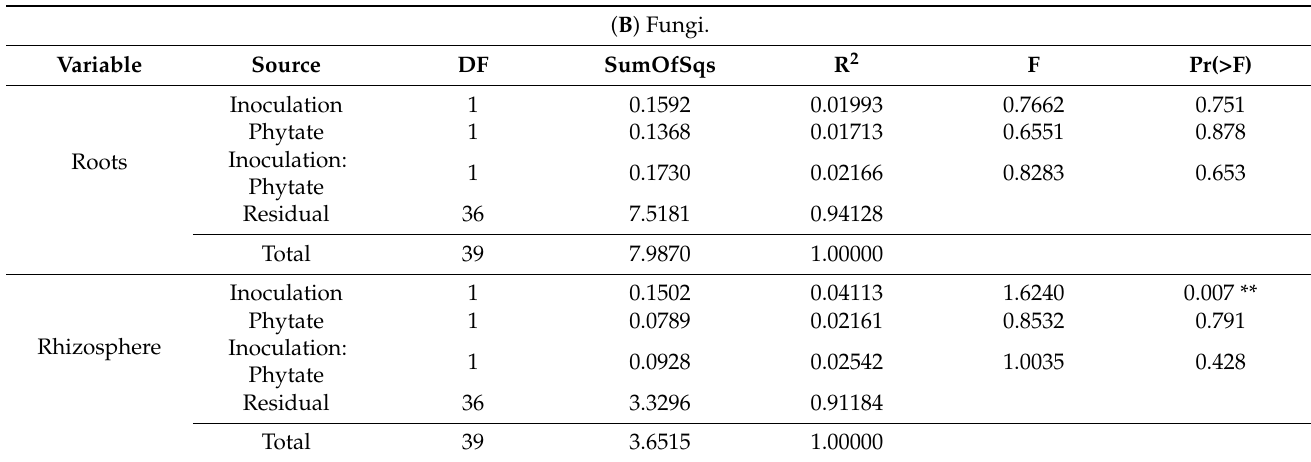
Table 2. Cont. ( B ) Fungi.